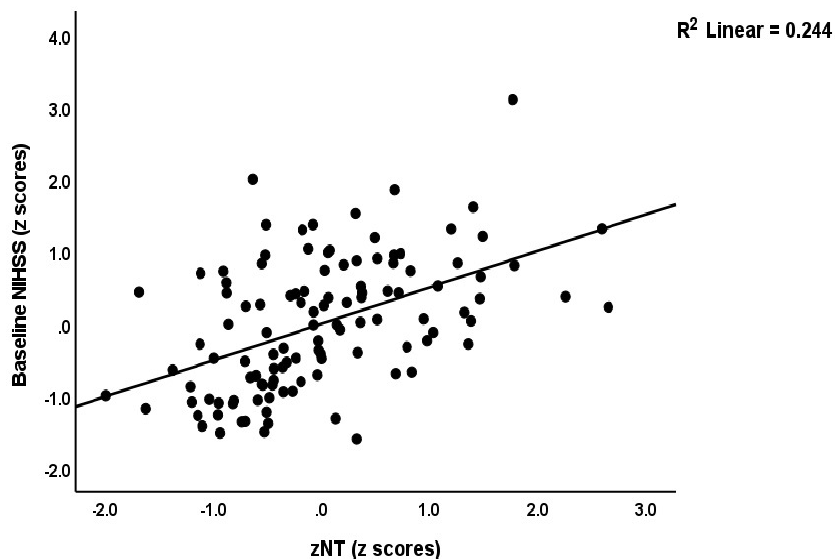
Figure 3. Partial regression of the baseline National Institutes of Health Stroke Scale (NIHSS) score on the neurotoxicity (zNT) index (after adjusting for age, sex, BMI, and smoking).